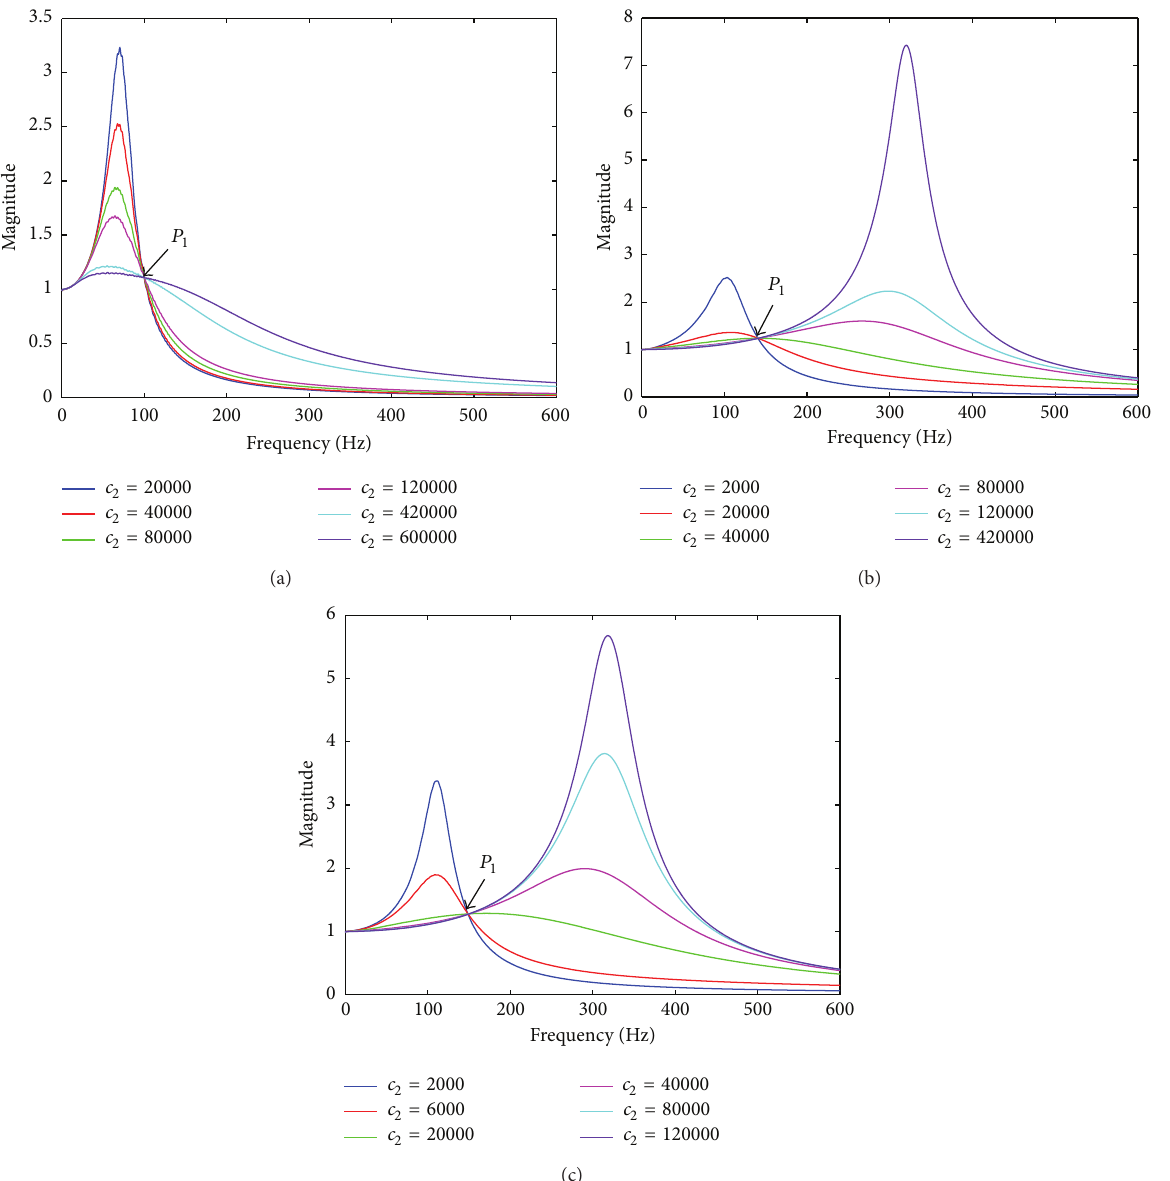
Figure 24: Force transmissibility curves of CM under 100 N FE cases. (a) 𝑛 1 = 1.5 ; (b) 𝑛 1 = 1 ; (c) 𝑛 1 = 0.85